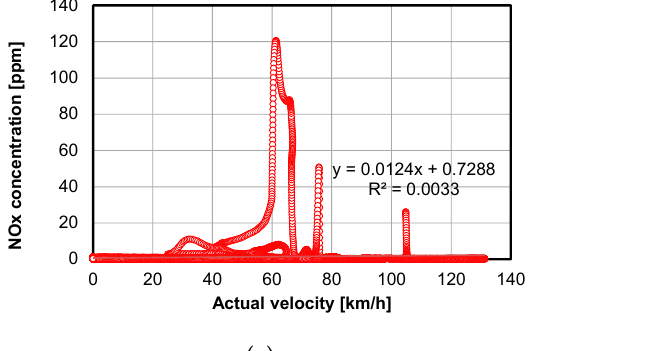
Energies 2022 , 15 , x FOR PEER REVIEW 17 of 40